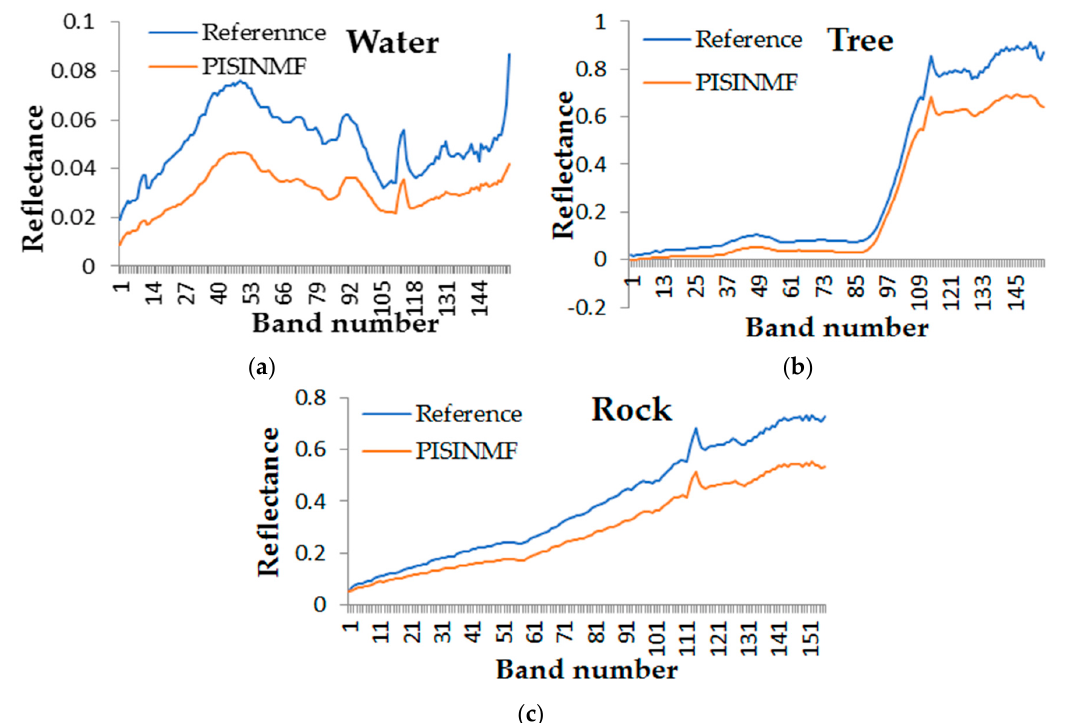
Figure 15. Results on the SAMSON image: Comparison of the reference spectra (blue line) with the Table 10. SAD results on the AVIRIS Cuprite data.